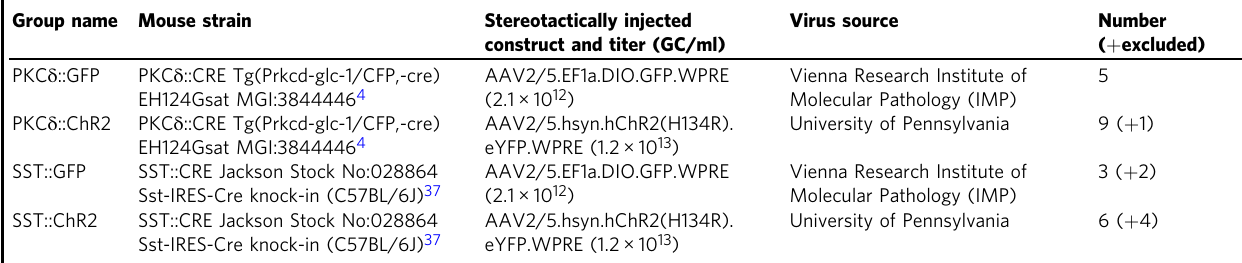
Table 2 Group assignments and sample sizes for ofMRI. Group name Mouse strain Stereotactically injected construct and titer